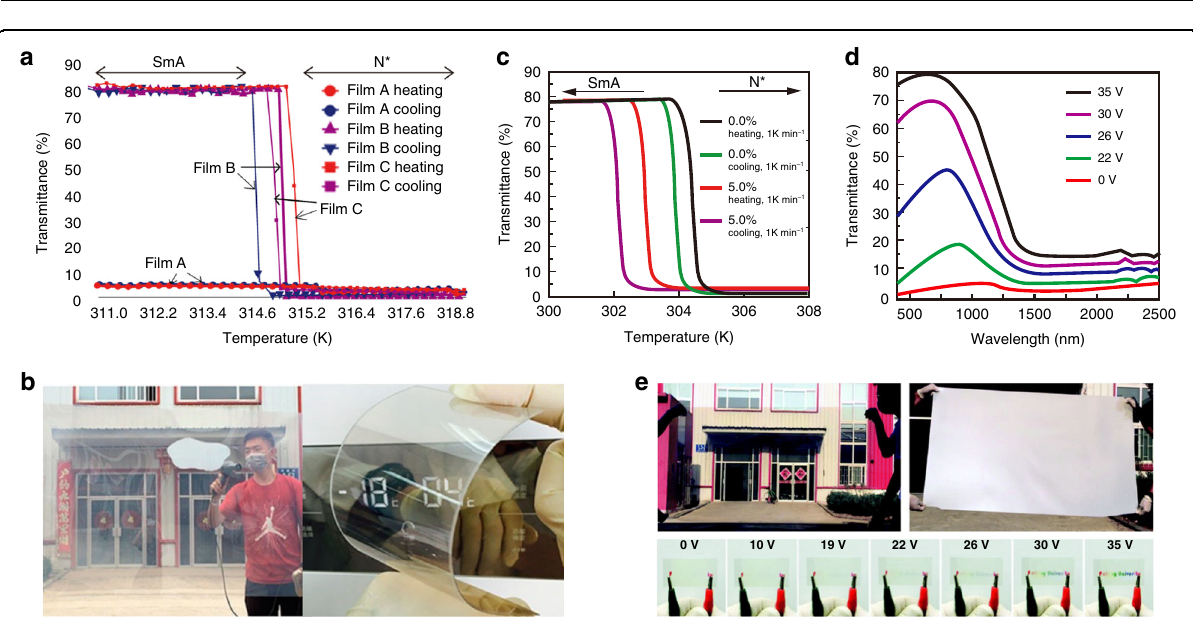
Fig. 18 Light protection strategies for buildings. a Graph of the transmittance of the sample as a function of temperature. b The prepared large- area fi lms and their bending properties. a, b Reproduced with permission from ref. 181 . Copyright 2017, American Chemical Society. c Graph of the transmittance of the sample as a function of temperature. d Graph of the transmittance of the sample as a function of wavelength for different voltages. e The prepared large-area fi lms and their effects at different voltages. Reproduced with permission from ref. 21 . Copyright 2017, Royal Society of